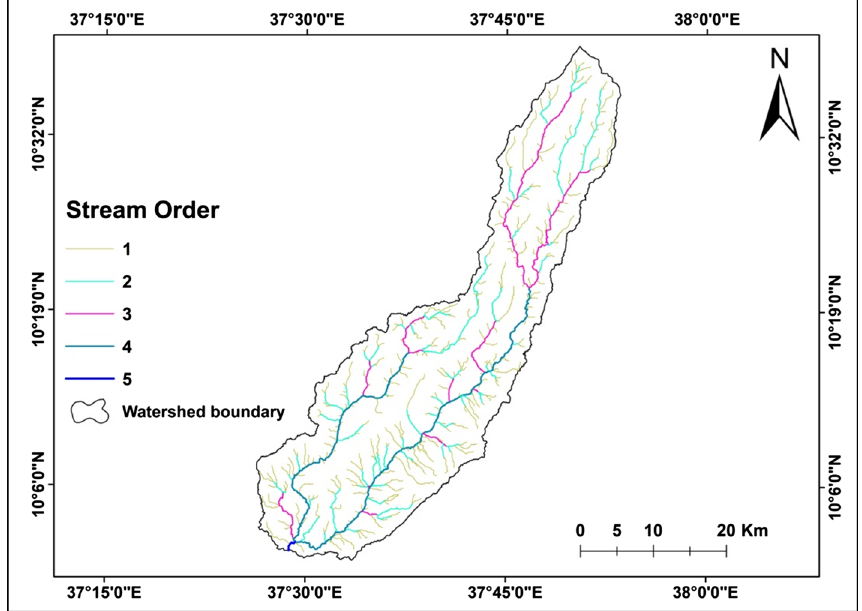
Fig. 3 Stream order map of